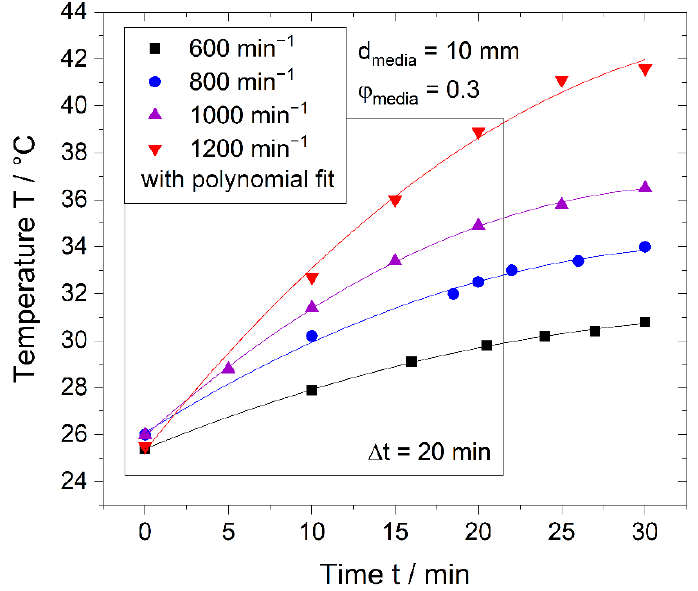
Figure 2. Temperature of cooling fluid for mechanochemical milling at varied rotational speeds, ϕ media = 0.3, d media = 10